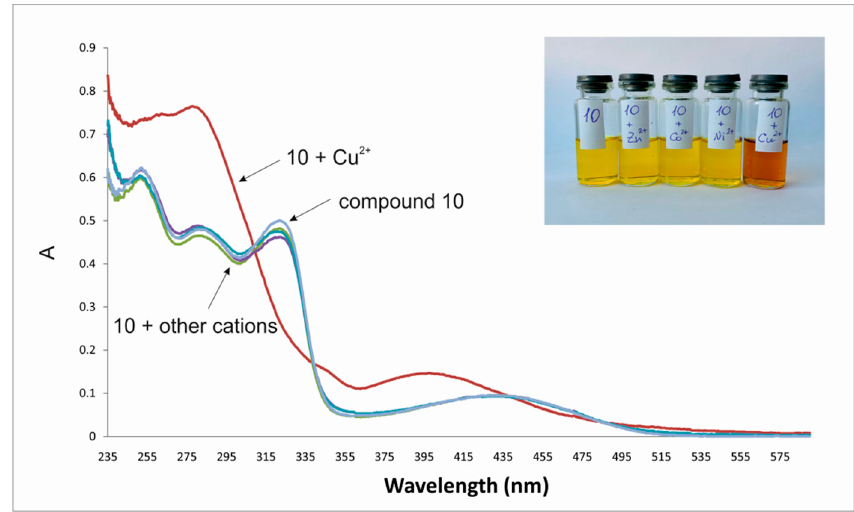
Figure 2. UV-vis spectra of compound 10 (1 × 10 − 5 M) without/with 10-fold excess of d-metal (II) cations (Zn 2+ , Co 2+ , Ni 2+ , Cu 2+ ) (CH 3 OH-CHCl 3 (1:1), t = 25 °C). The insert contains photos of real samples.